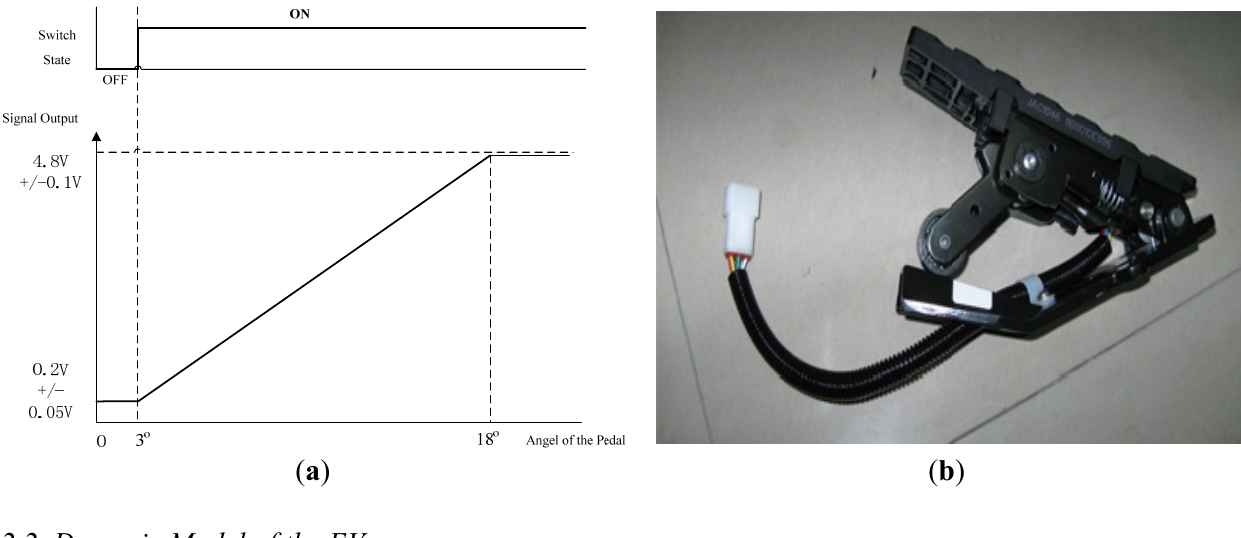
Figure 2. Operation principle and mechanical structure of the brake pedal: ( a ) signal output for electric brake pedal; and ( b ) interface and outline of the brake